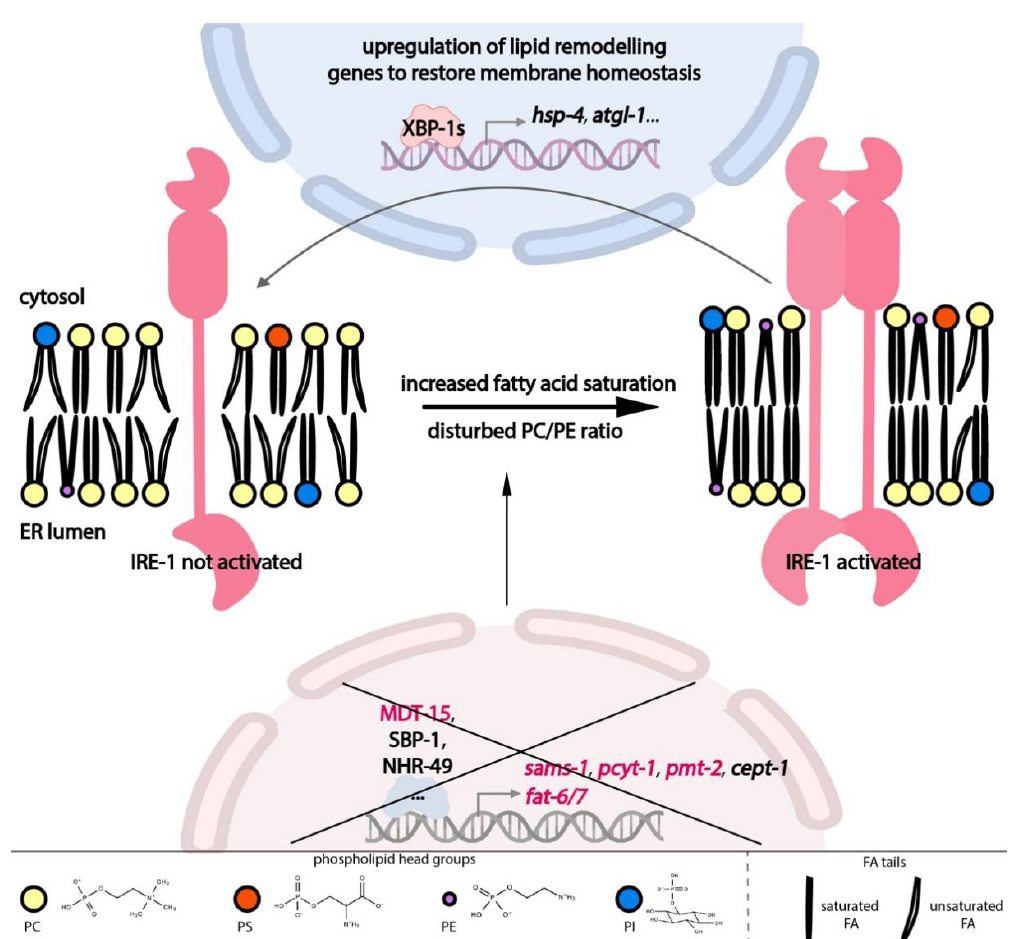
Figure 2. Overview of the bidirectional interplay between lipid metabolism and the IRE-1 branch of the UPR-ER in Caenorhabditis elegans . Disturbed ER membrane lipid composition is caused by the loss of mdt-15 or fat-6/7 , which cause increased FA saturation, or by the loss of mdt-15 , sams-1 , pcyt-1 , or pmt-2 , which cause disturbed PC/PE ratios. All these disturbances are direct triggers for IRE-1 activation, i.e., independent of protein misfolding. Activated IRE-1 upregulates compensatory genes, which remodel lipid metabolism and restore a proper lipid environment in the ER. Genes colored in red have been experimentally shown to cause IRE-1 activation in C. elegans when inactivated. Abbreviations: atgl-1 : adipose triglyceride lipase; cept-1 : choline/ethanolaminephosphotransferase; FA: fatty acid; fat-6/-7 : fatty acid desaturase 6/7; hsp-4 : heat shock protein 4; IRE-1: IRE1 kinase related; MDT-15: mediator 15; NHR-49: nuclear hormone receptor 49; PC: phosphatidylcholine; pcyt-1 : phosphocholine cytidylyltransferase; PE: phosphatidylethanolamine; PI: phosphatidylinositol; pmt-2 : phosphoethanolamine methyltransferase; PS: phosphatidylserine; sams-1 : S-adenosyl methionine synthetase; SBP-1: sterol regulatory element binding protein; XBP-1: X-box binding protein homolog. (Some parts of the image were created with BioRender.com, Toronto, ON,